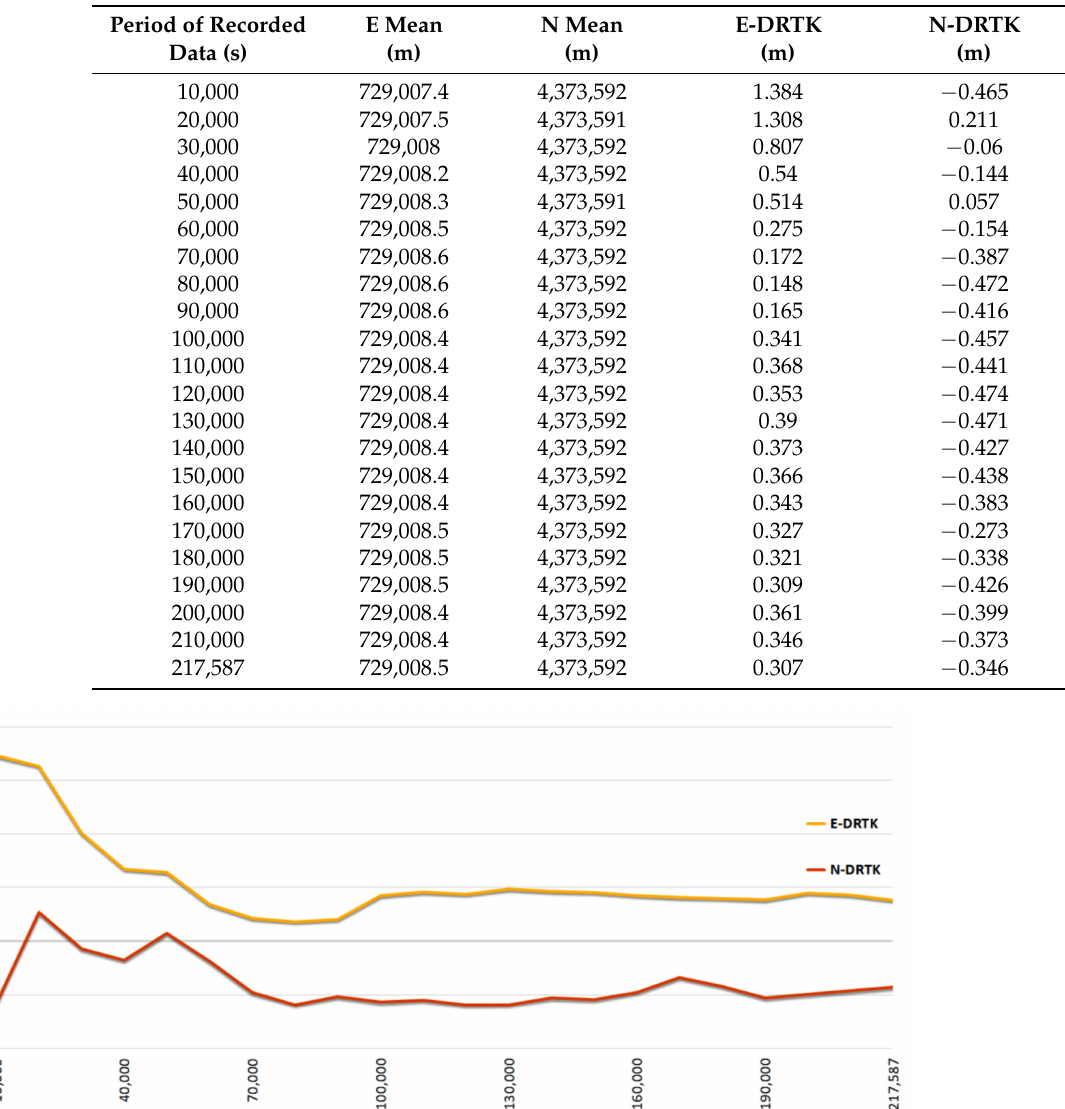
Table A5. Xiaomi Mi 8 device period of recorded data, and coordinate means for E and N. Differences between the reference data and coordinate means (E-DRTK and N-DRTK). Real-time techniques were